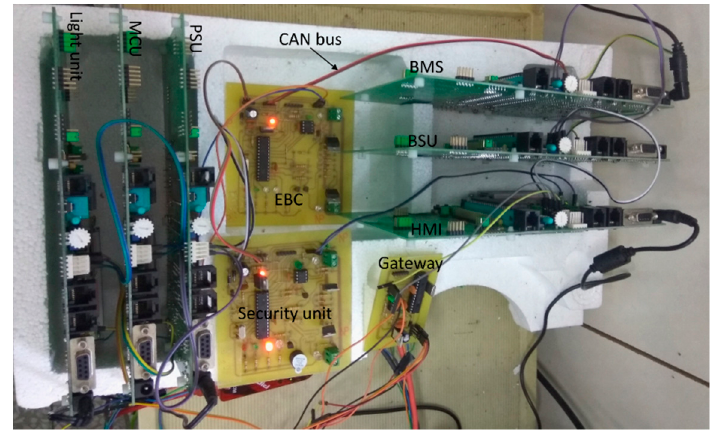
Figure 12. EnergyBus system simulator. Table 3. Transmit process data objects (T-PDOs) of the EnergyBus system